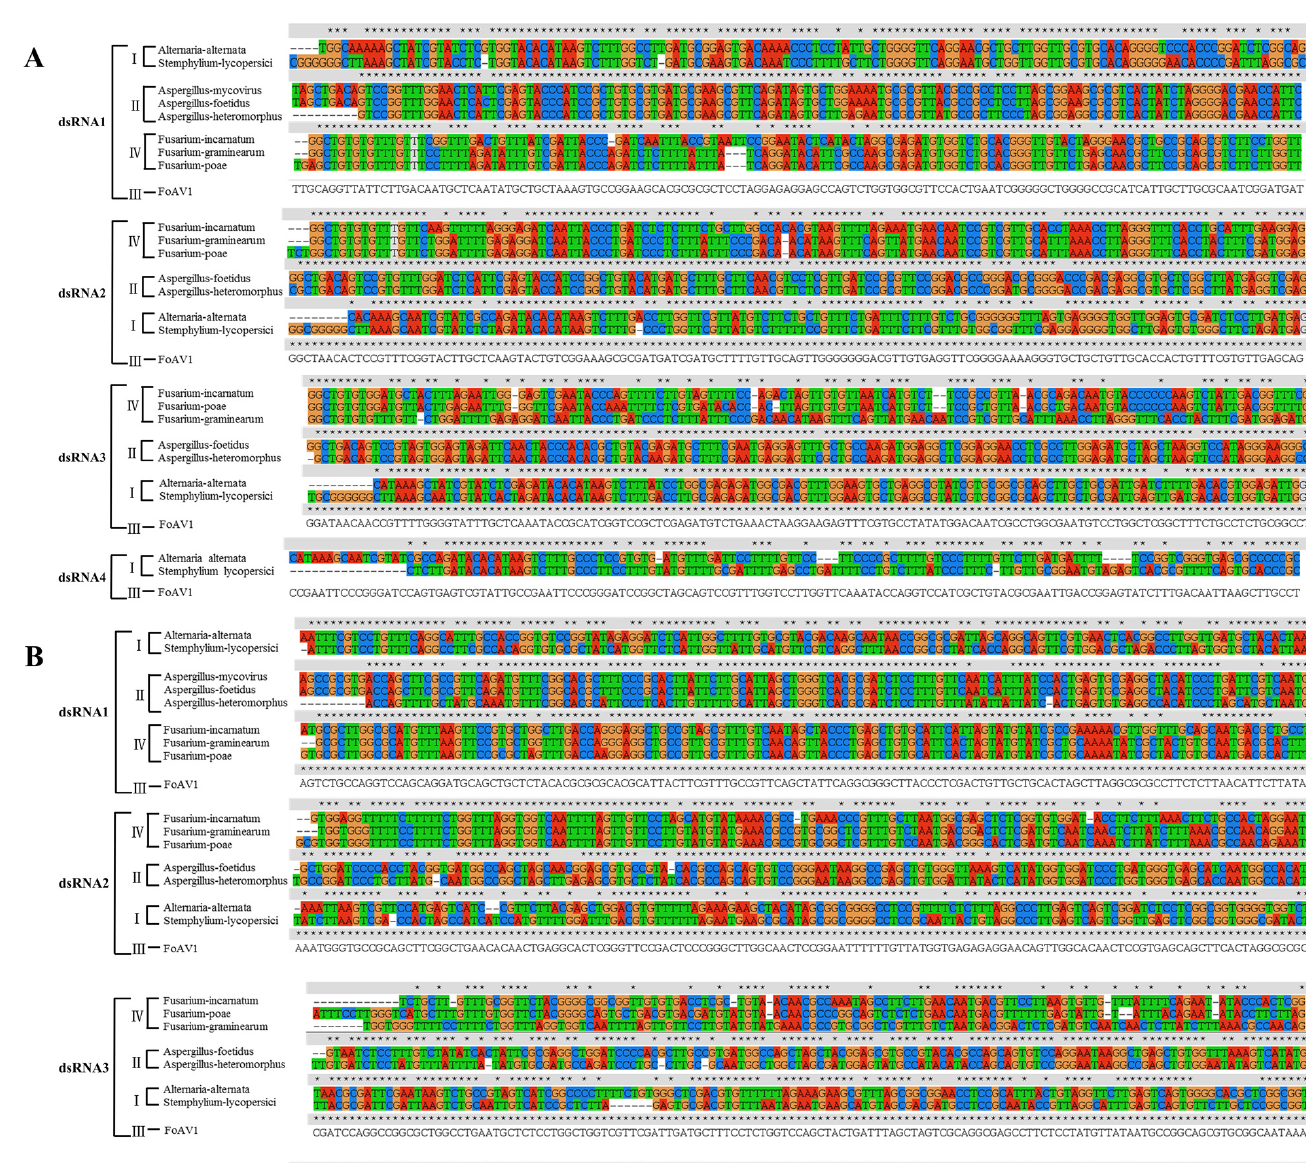
Figure 5. Multiple alignment of the 5 ′ ( A ) and 3 ′ ( B )-UTRs of each FoAV1 dsRNA segment compared to equivalent alternavirus UTRs.